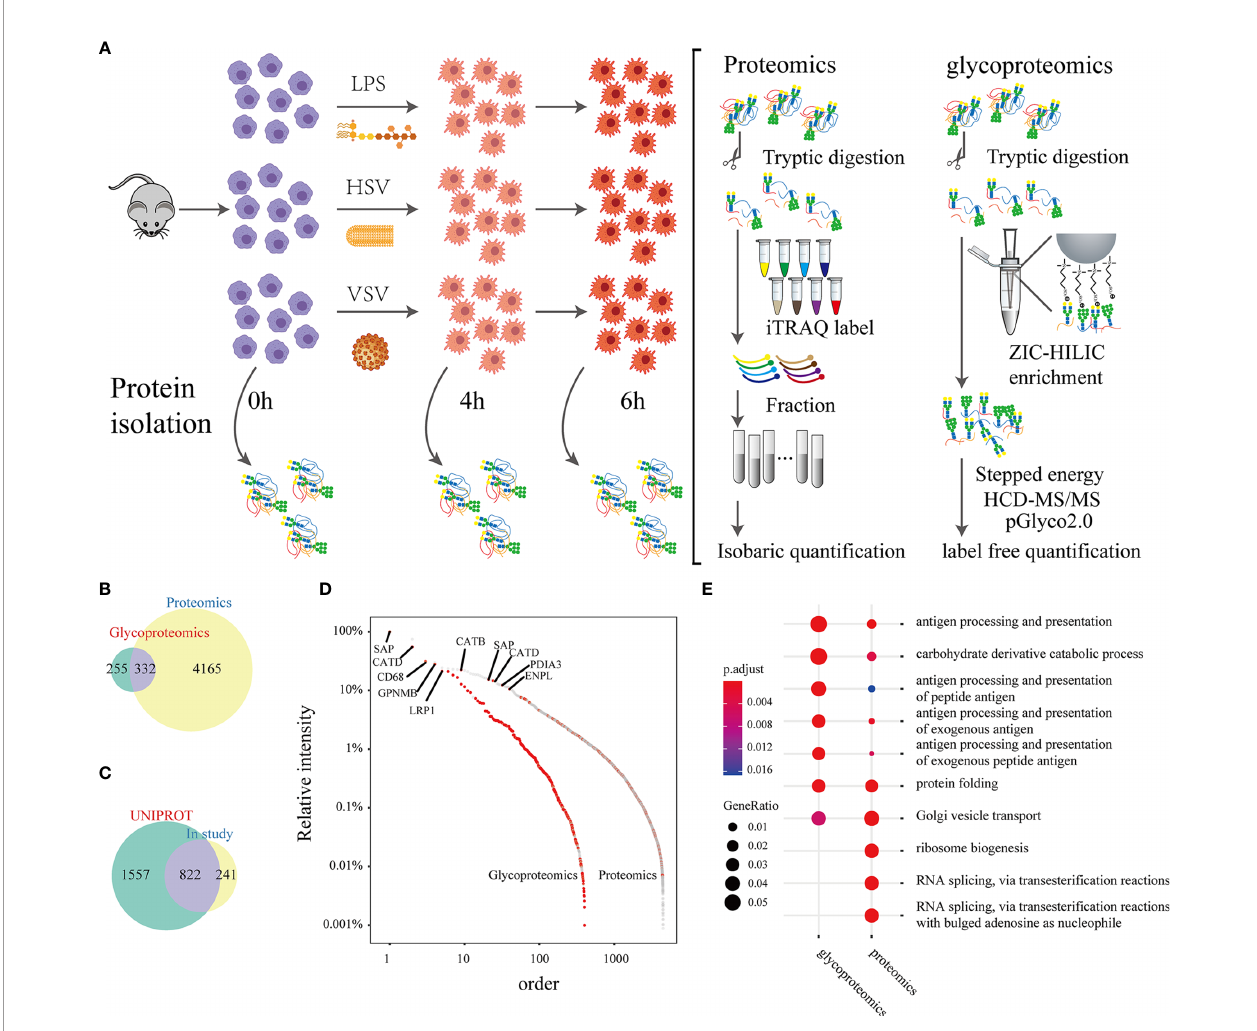
FIGURE 1 | A brief summary of proteomic and glycoproteomic analyses. Experimental work fl ow: Peritoneal macrophages were extracted from mice and stimulated with LPS, HSV or VSV. Lysates were collected from macrophages at 4 hours and 6 hours after stimulation (A) . The Venn plot shows the proteins identi fi ed by proteomics and glycoproteomics (B) . The Venn plot of glycosylation sites that were identi fi ed in this study and recorded in the UNIPROT database (C) . Abundance distribution of the proteins and glycoproteins identi fi ed by the proteomic and glycoproteomic analyses (the relative intensity of the proteins was calculated by the maximum intensity in either the proteome or glycoproteome) (D) . Gene Ontology analysis of the proteomic and glycoproteomic data (E)